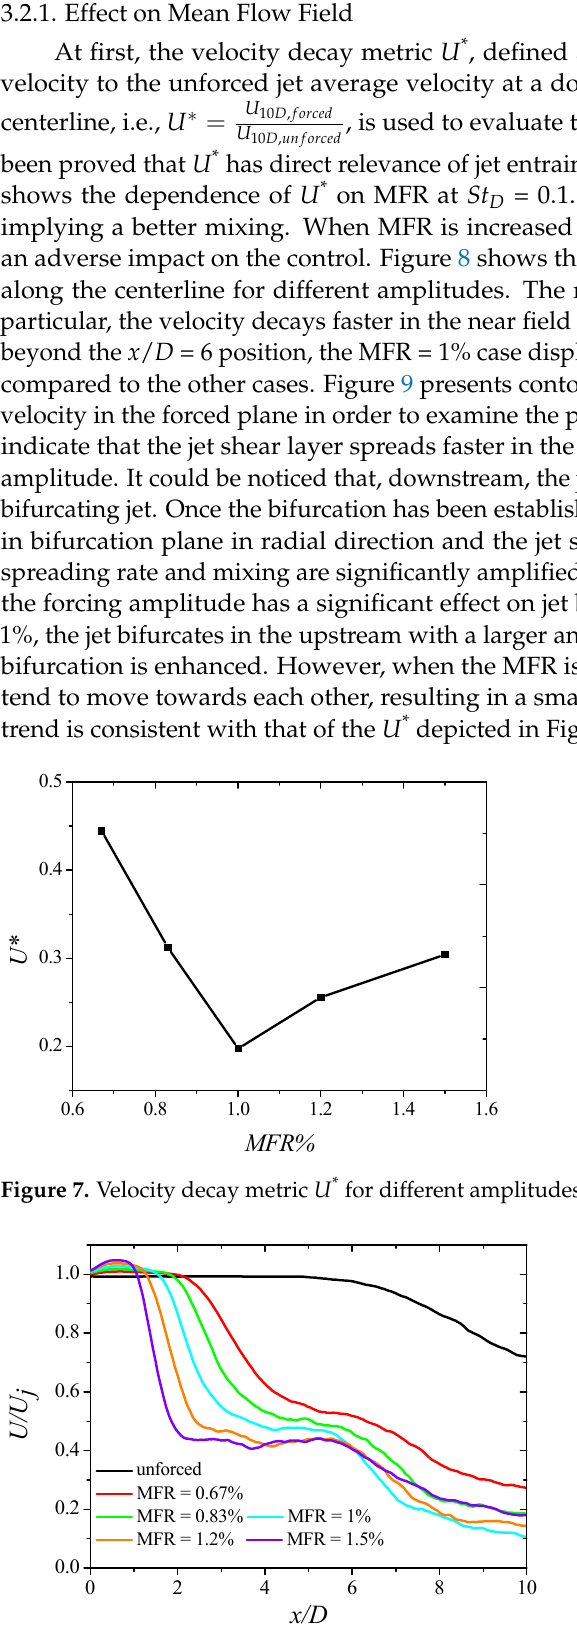
Figure 8. Decay of the time-averaged streamwise velocity along the centerline for different ampli- tudes.